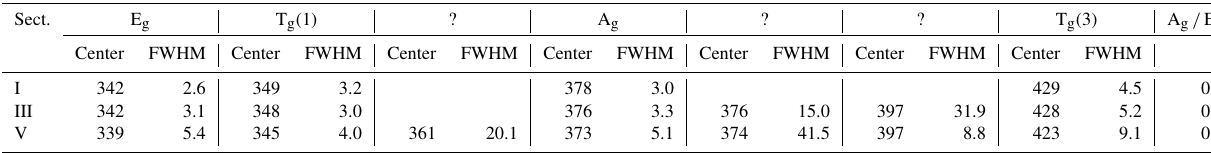
Table 3. Frequencies and FWHM of observed Raman modes of pyrite measured on BIB polished surface (cm − 1 ).